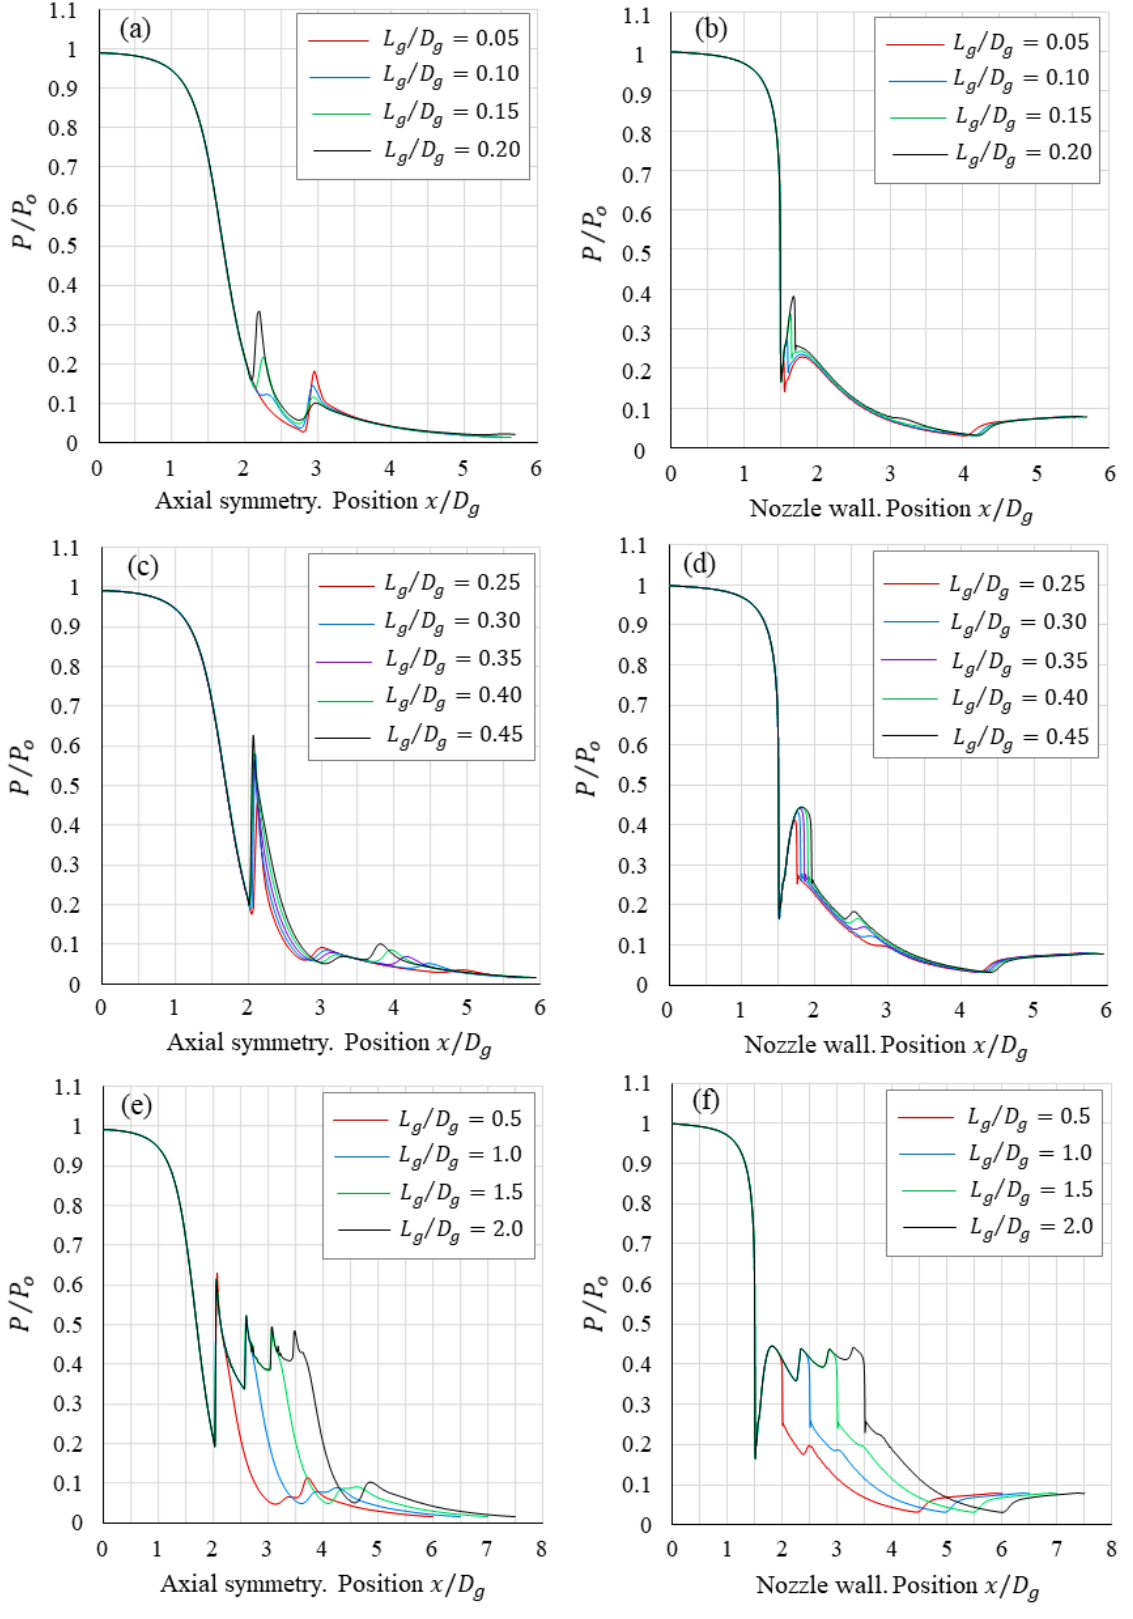
Figure 6.Pressure patterns. Throat length in the range (a) 0.05 ≤ L g /D g ≤ 0.2; (b) 0.25 ≤ L g /D g ≤ 0.45 y (c) 0.5 ≤ L g /D g ≤ 2..Source: